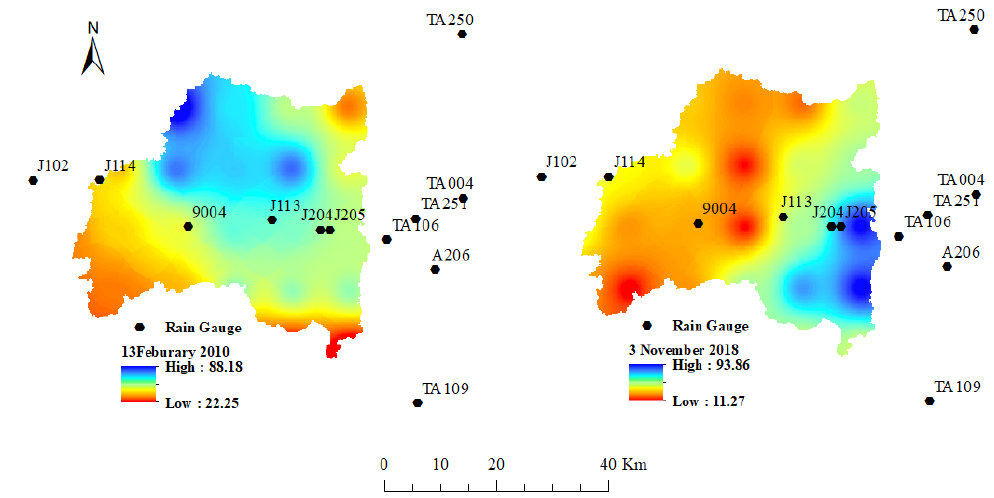
Figure 2. Rainfall totals for the 13 February 2010 and the 3 November 2018 storm as estimated by the IMERG Early run product.